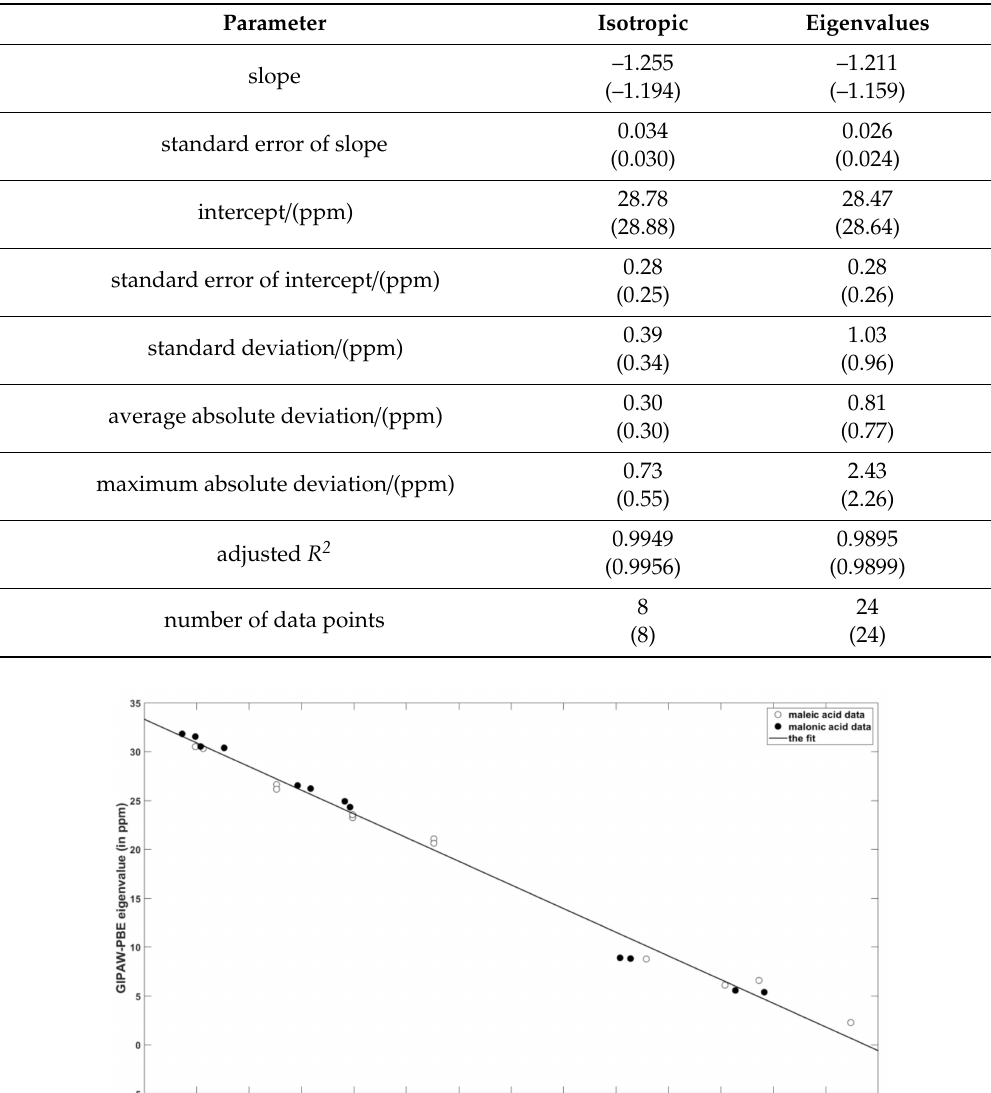
Table 1. Statistical evaluation of the agreement between the GIPAW-PBE (in parentheses, the GIPAW-revPBE) chemical shieldings and experimental chemical shifts for protons of maleic and malonic acids.